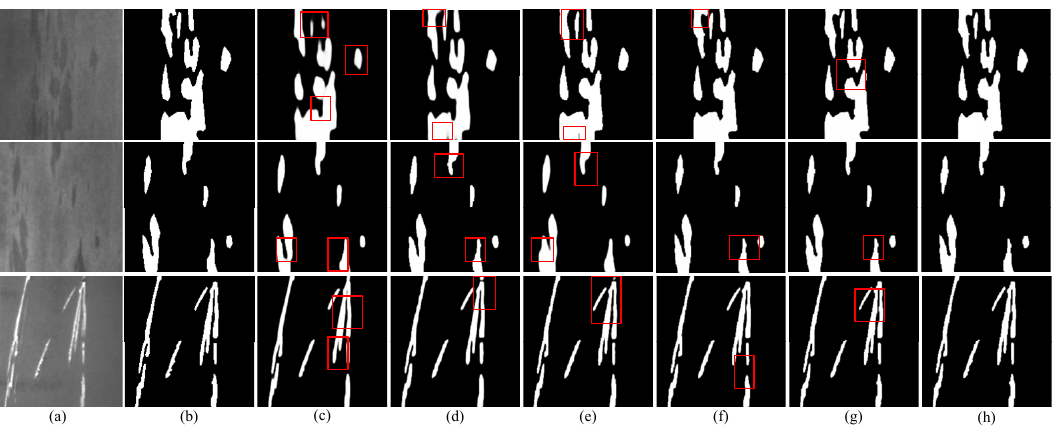
Table 1. The results of using different key components.